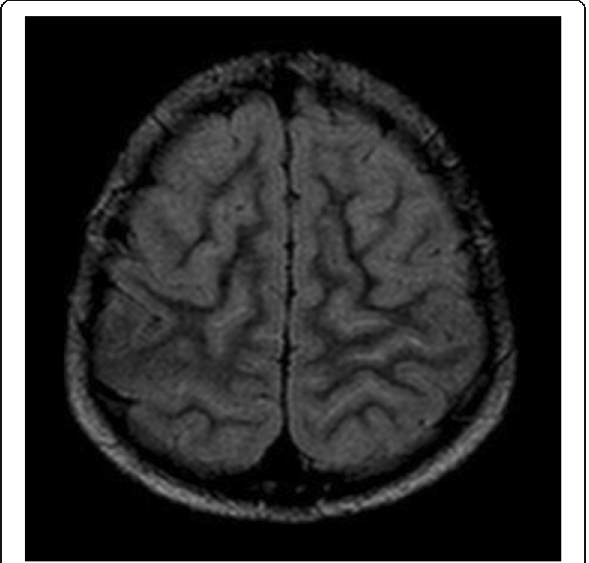
Fig. 17 Axial FLAIR image in a 12-year-old girl with Down syndrome and moyamoya pattern depicting the classical ivy sign , corresponding to areas of absence of normal FLAIR suppression of CSF within cortical sulci. This sign probably represents slow flow in leptomeningeal collaterals. The exam was performed without general anesthesia